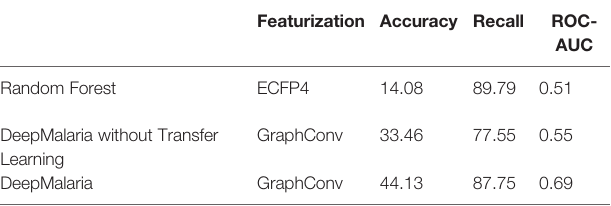
TABLE 5 | Comparison of different models on test